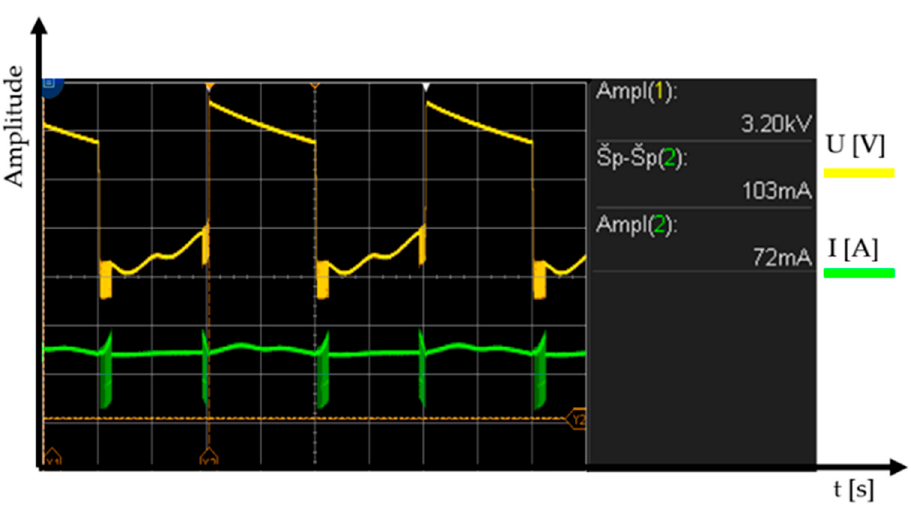
Figure 7. Output voltage and current in the high-voltage transformer (MOT).